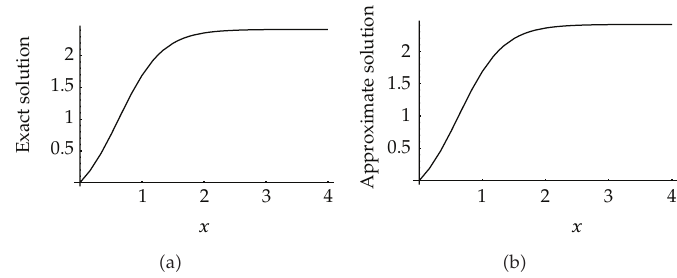
Figure 1: Comparison of approximate solutions with the exact solutions for Example 4.1. (cid:3)(cid:3) a (cid:4) : exact solu- tion; (cid:3) b (cid:4) : approximate solution. (cid:4) .